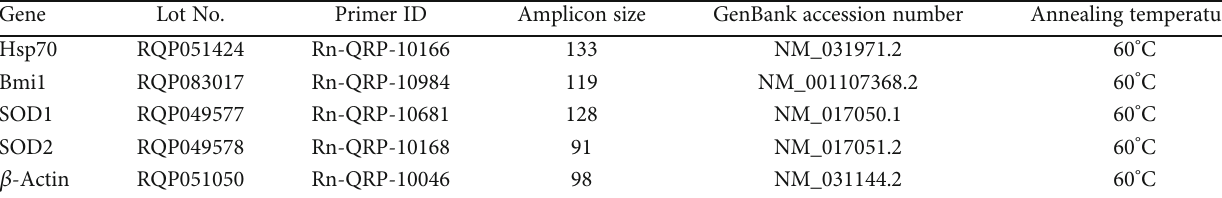
Table 1: Primers used for quantitative RT-PCR.